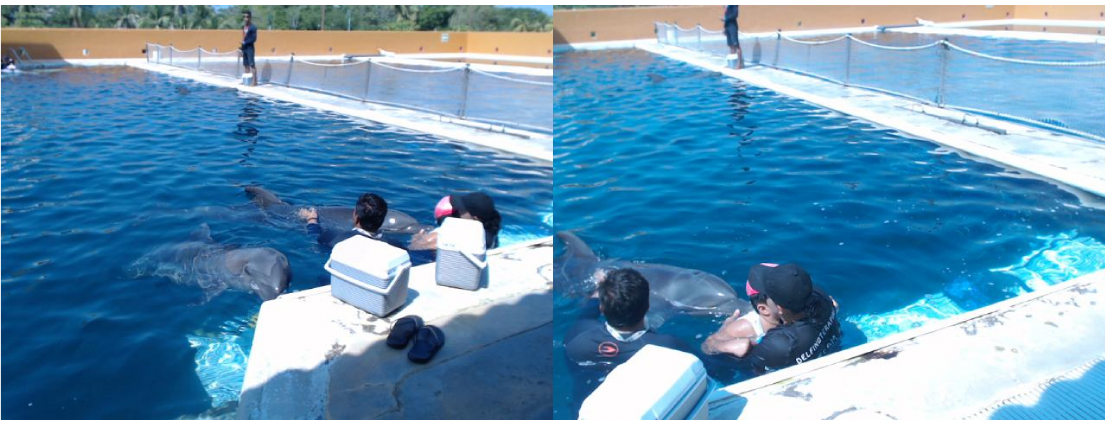
Figure 25. Original two-view images from USB-Cam1 S and USB-Cam2 S